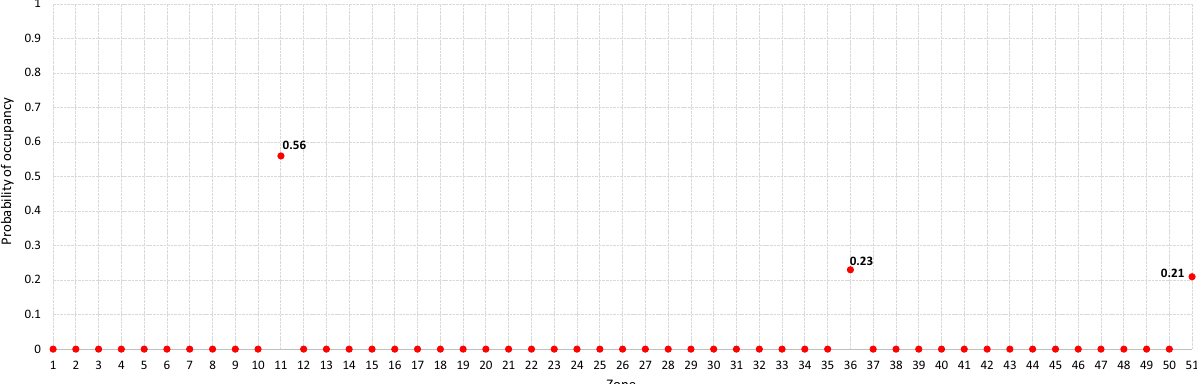
Figure 5: Approach of QASA. It records the zones each joint occupies and fi nally calculates the percentage visit to each zone. The observation was made upon an individual who was standing,